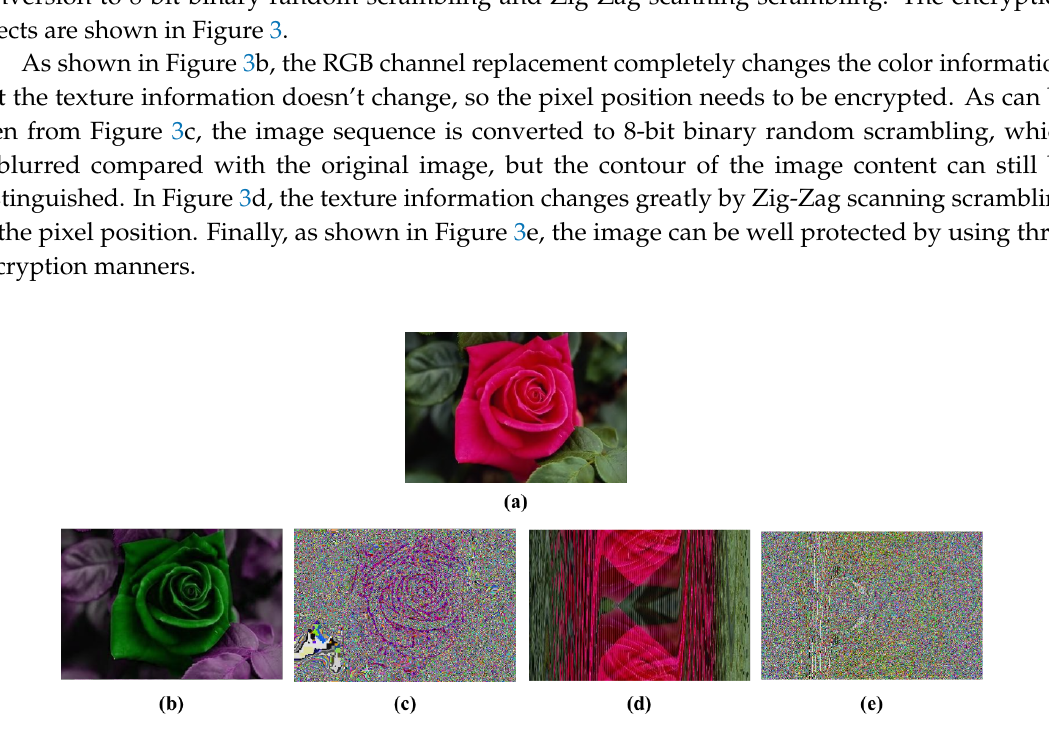
Figure 3. Encryption effect. ( a ) Original image. ( b ) ChannelEnc image. ( c ) SequenceEnc image. ( d ) Zig-ZagEnc image. ( e ) ImgEnc image.